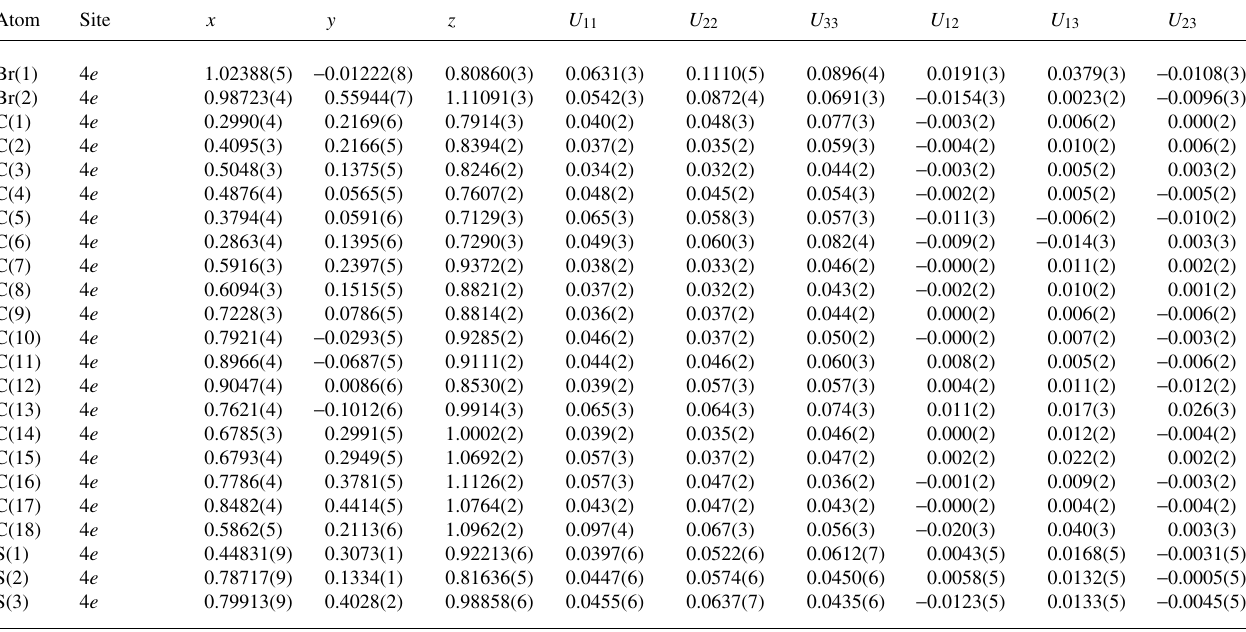
Table 3. Atomic coordinates and displacement parameters (in Å 2 ) .